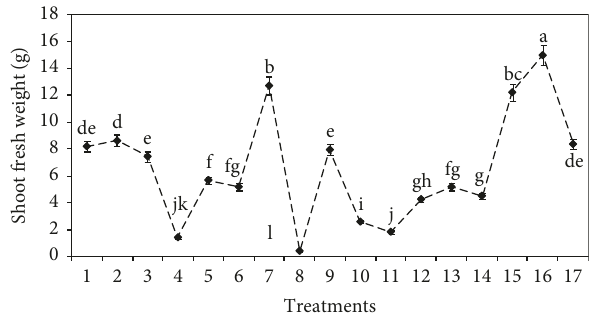
Figure 7: Impact of biosorbed water by various biosorbents (or- ange peels, pomegranate peels, and peanut peels) on root length of mung bean after 7 days of seed germination. T1, negative control; T2, 50mg kg − 1 ; T3, pomegranate peel biosorbed water +50mg kg − 1 ; T4, peanut peel biosorbed water +50mg kg − 1 ; T5, orange peel biosorbed water +50mg kg − 1 ; T6, 100mg kg − 1 ; T7, pomegranate peel biosorbed water +100mg kg − 1 ; T8, peanut peel biosorbed water +100 mg kg − 1 ; T9, orange peel biosorbed water +100 mg kg − 1 ; T10, 150mg kg − 1 ; T11, pomegranate peel biosorbed water +150 mg kg − 1 ; T12, peanut peel biosorbed water +150 mg kg − 1 ; T13, orange peel biosorbed water +150 mg kg − 1 ; T14, 200mg kg − 1 ; T15, pomegranate peel biosorbed water +200 mg kg − 1 ; T16, peanut peel biosorbed water +200 mg kg − 1 ; T17, orange peel biosorbed water +200 mg kg − 1 . Vertical bars (I): standard error (mean of 3 replicates). Alphabets on vertical bars: significant difference ( P ≤ 0 . 05) evaluated by the LSD